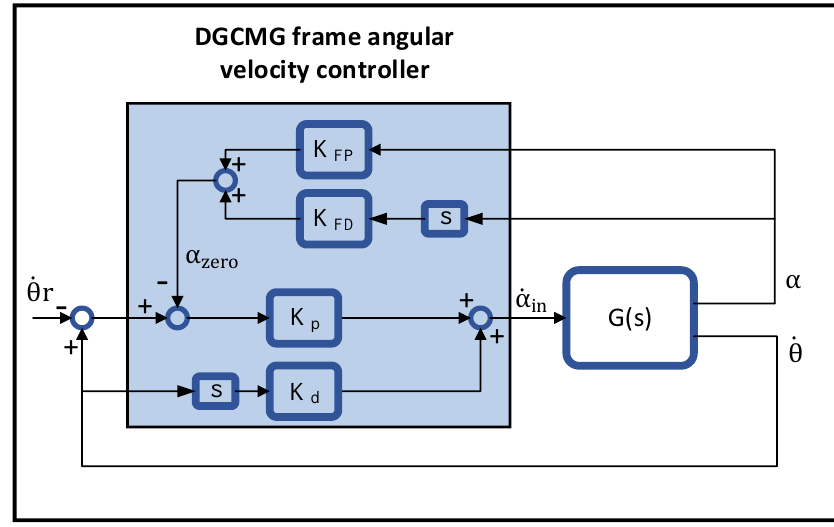
Figure 8. Closed-loop system using the SGCMG frame angular velocity controller.